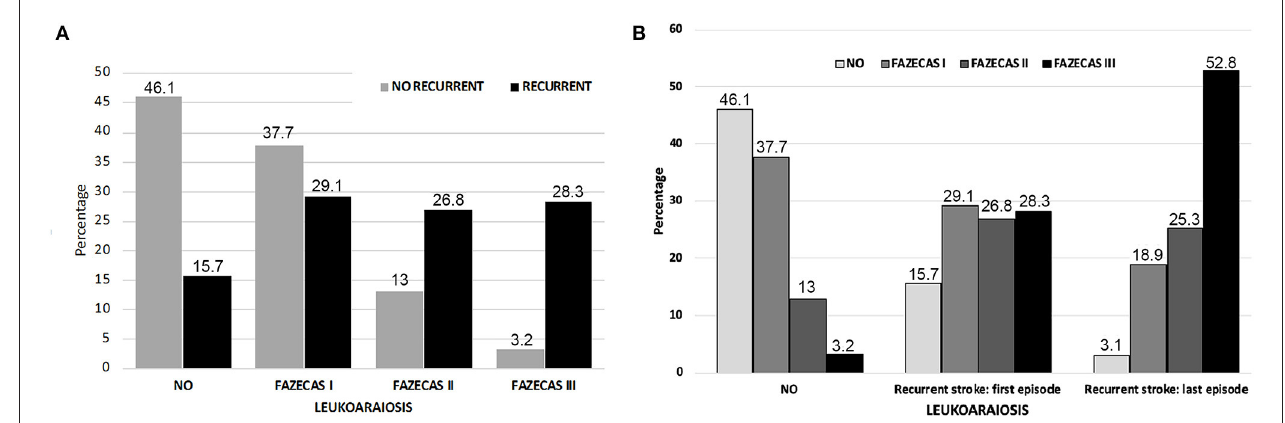
FIGURE 2 | (A) Percentage of patients with recurrence according to degree of LA in the initial MRI study. (B) Degree of LA in patients who did not present a new stroke; in those who presented a new stroke at the time of the first and in the study conducted following the second stroke.